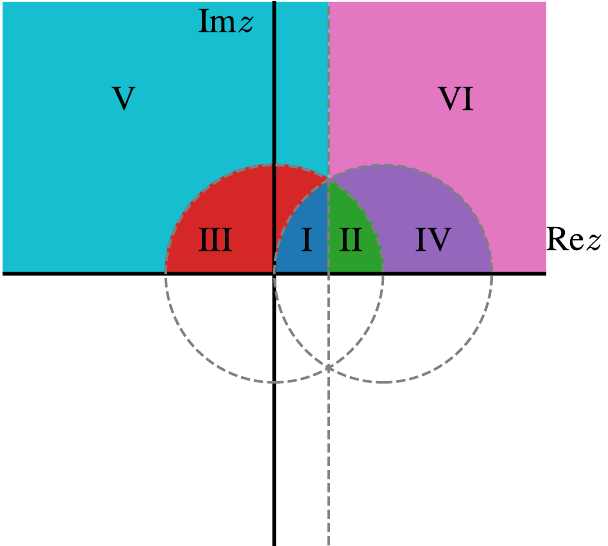
Figure 2. The complex z plane divides into 12 region under the symmetry S 3 × Z 2 of the three- point energy correlator. In this paper we will focus on region I, where the squeezed limit corresponds to z → 0